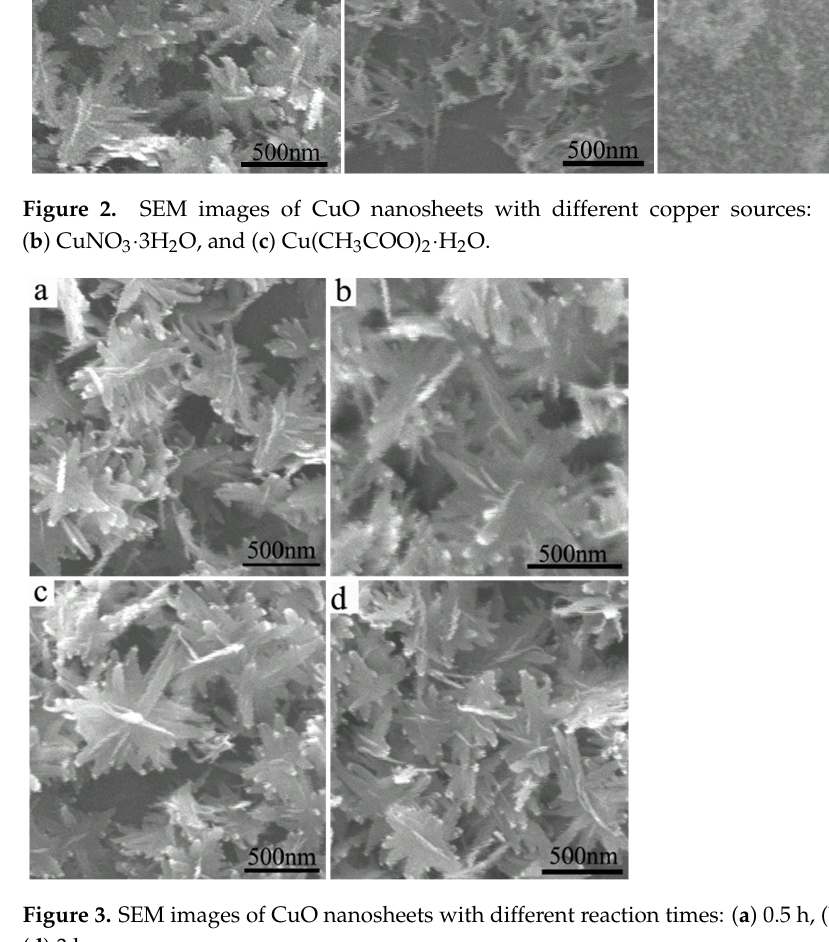
Figure 2. SEM images of CuO nanosheets with different copper sources: ( a ) CuSO 4 ·5H 2 O, ( b ) CuNO 3 ·3H 2 O, and ( c ) Cu(CH 3 COO) 2 ·H 2 O.